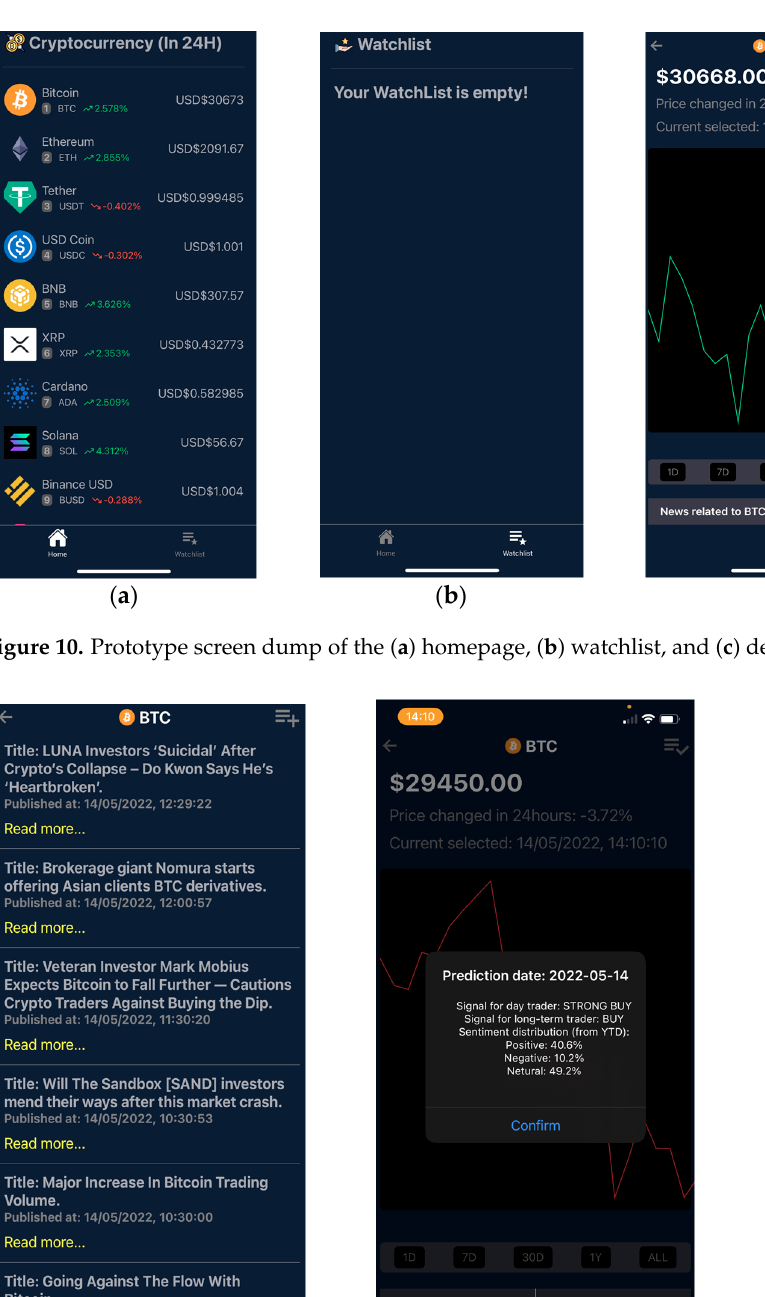
Figure 11. Prototype screen-dump of ( a ) news function and ( b ) prediction function.